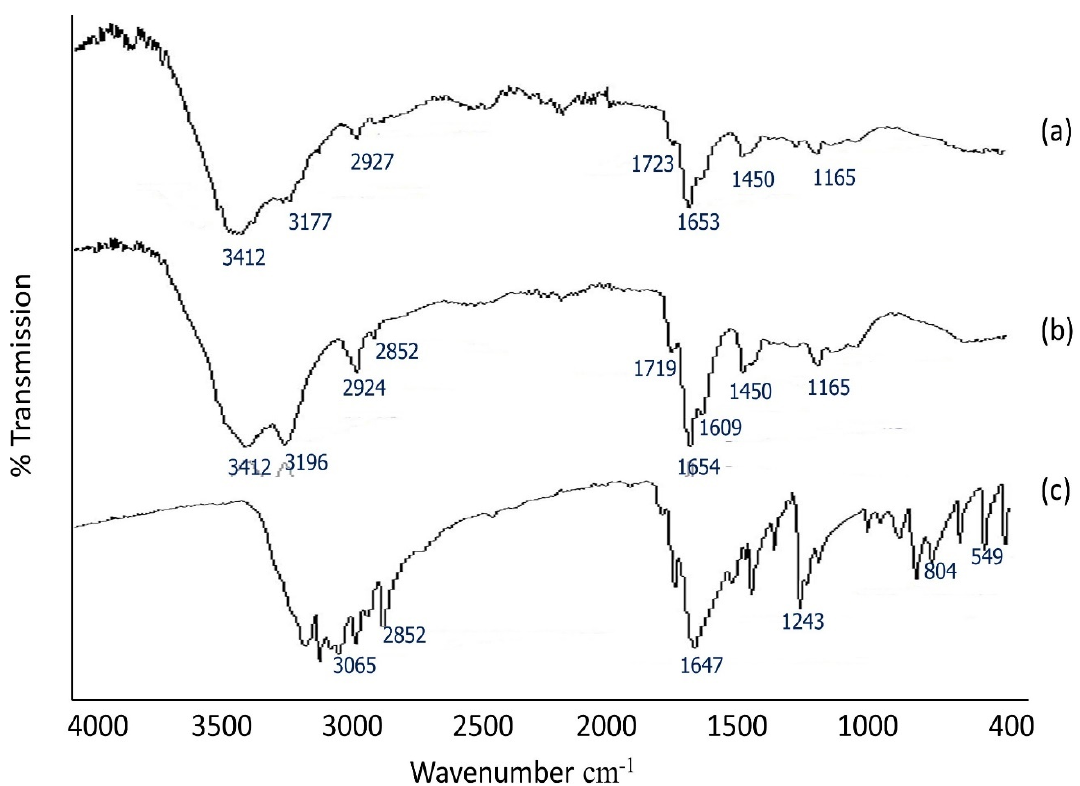
Figure 1. ATR-FTIR spectra of ( a ) Pure 5-FU, ( b ) 5-FULH, and ( c ) Unloaded hydrogels.